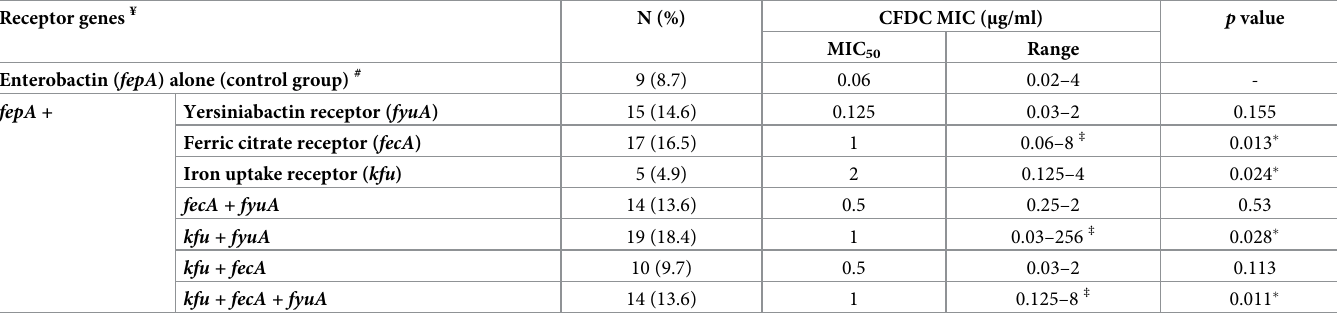
Table 3. Combinations of iron acquisition receptor genes found in the strains and their effect on CFDC MICs. Receptor genes ¥